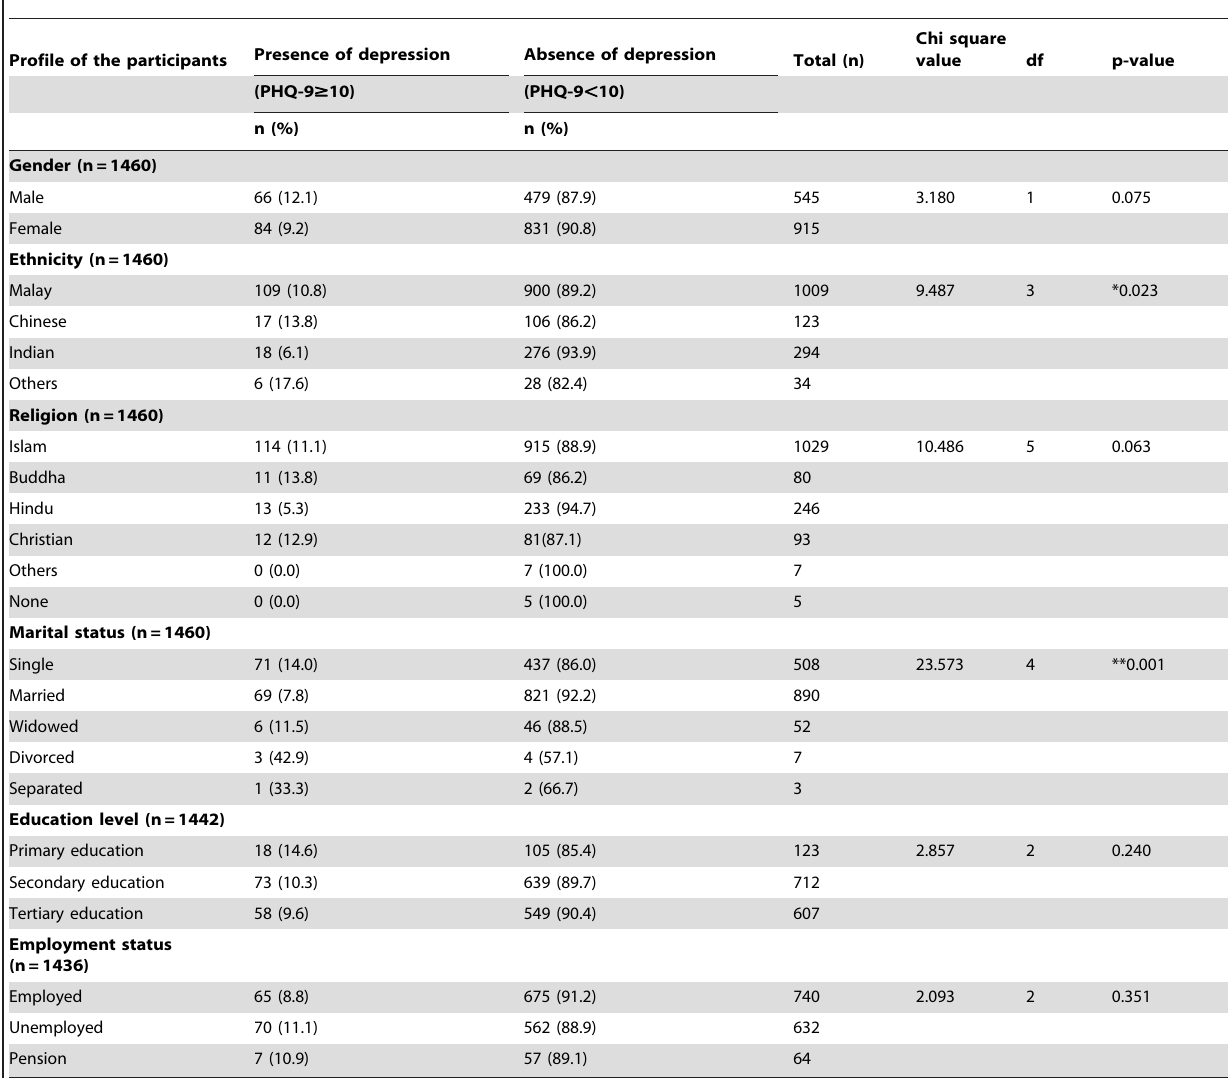
Table 1. Association of socio-demographic profiles with depression among participants.